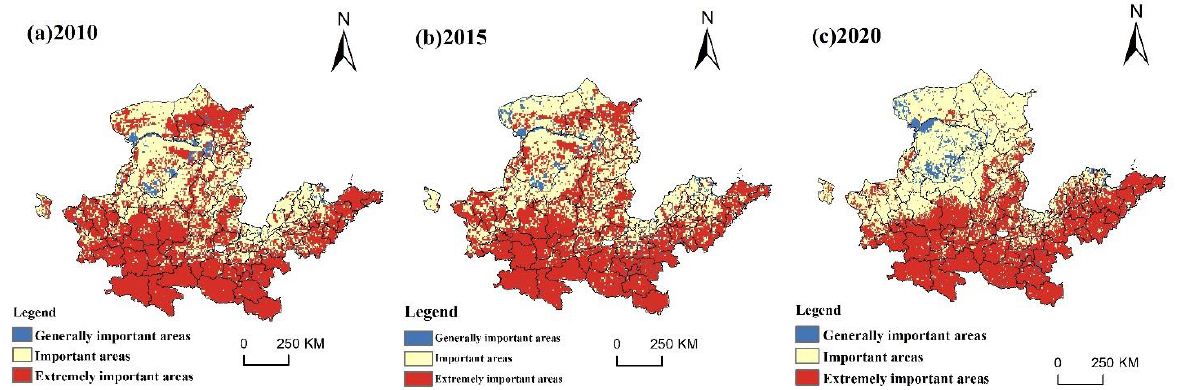
Figure 3. Spatial and temporal patterns of conservation levels of ecological importance from 2010 to 2020.